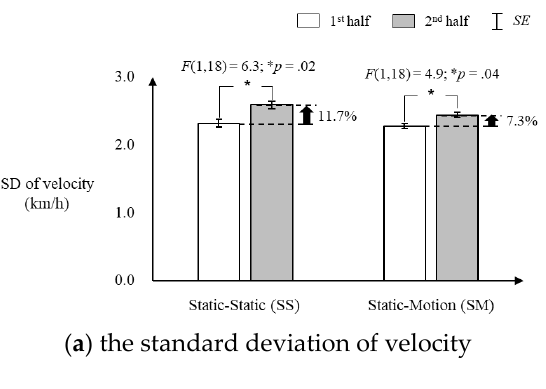
Figure 4. Changes in driving performance between the first-half and second-half driving sessions for the static (S) and motion (M) seat conditions.